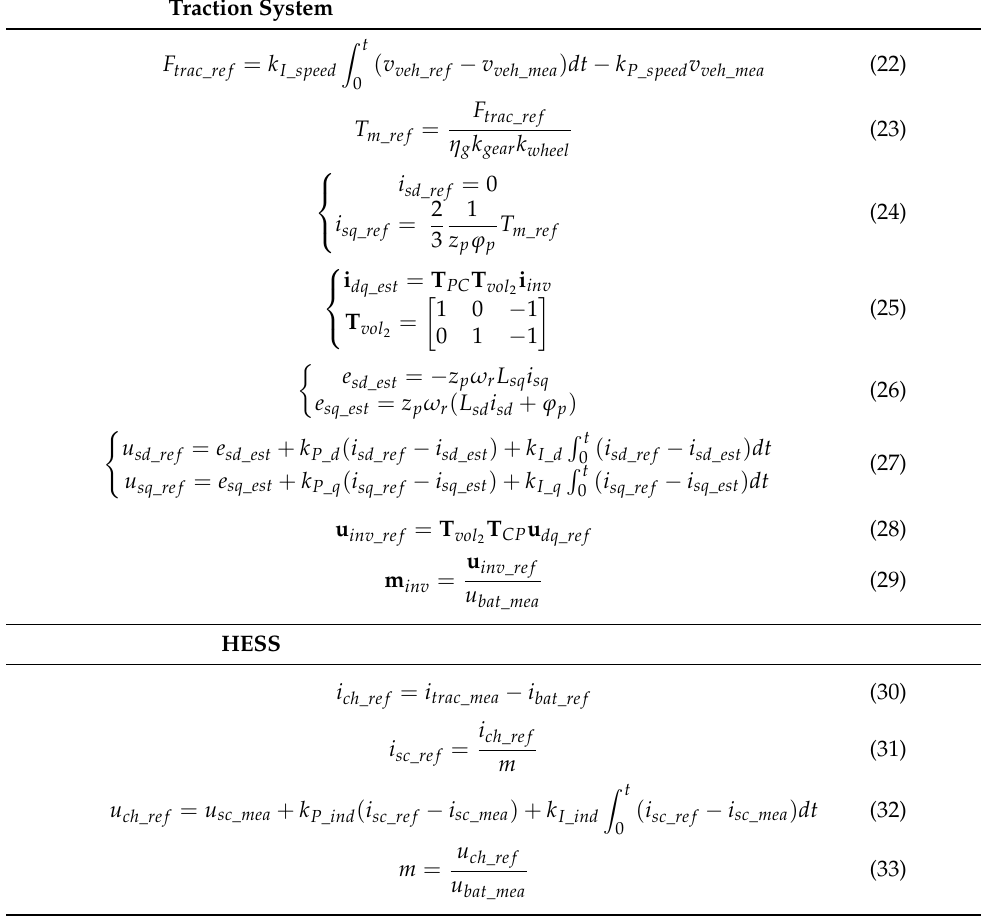
Table 1. Equations for the control scheme of the powertrain system. Traction